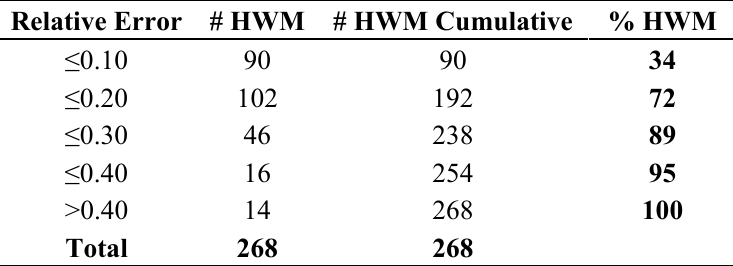
Table 11. Summary of USGS High Water Marks (HWM) vs. SLOSH-simulated maximum water level relative